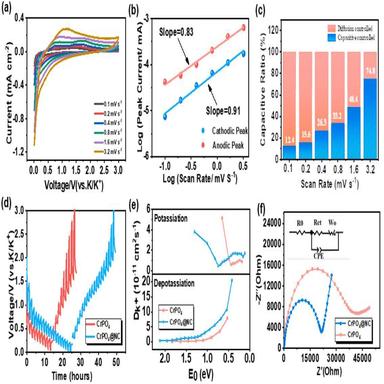
(a) CV profiles of CrPO4@NC at various sweep rates, (b) b value determination, (c) Contribution ratio of capacitive at different scan rates, (d) GITT profiles for CrPO4@NC and CrPO4 electrodes, (e) Ion diffusion coefficients calculated by GITT, (f) EIS of CrPO4@NC and CrPO4 electrodes.